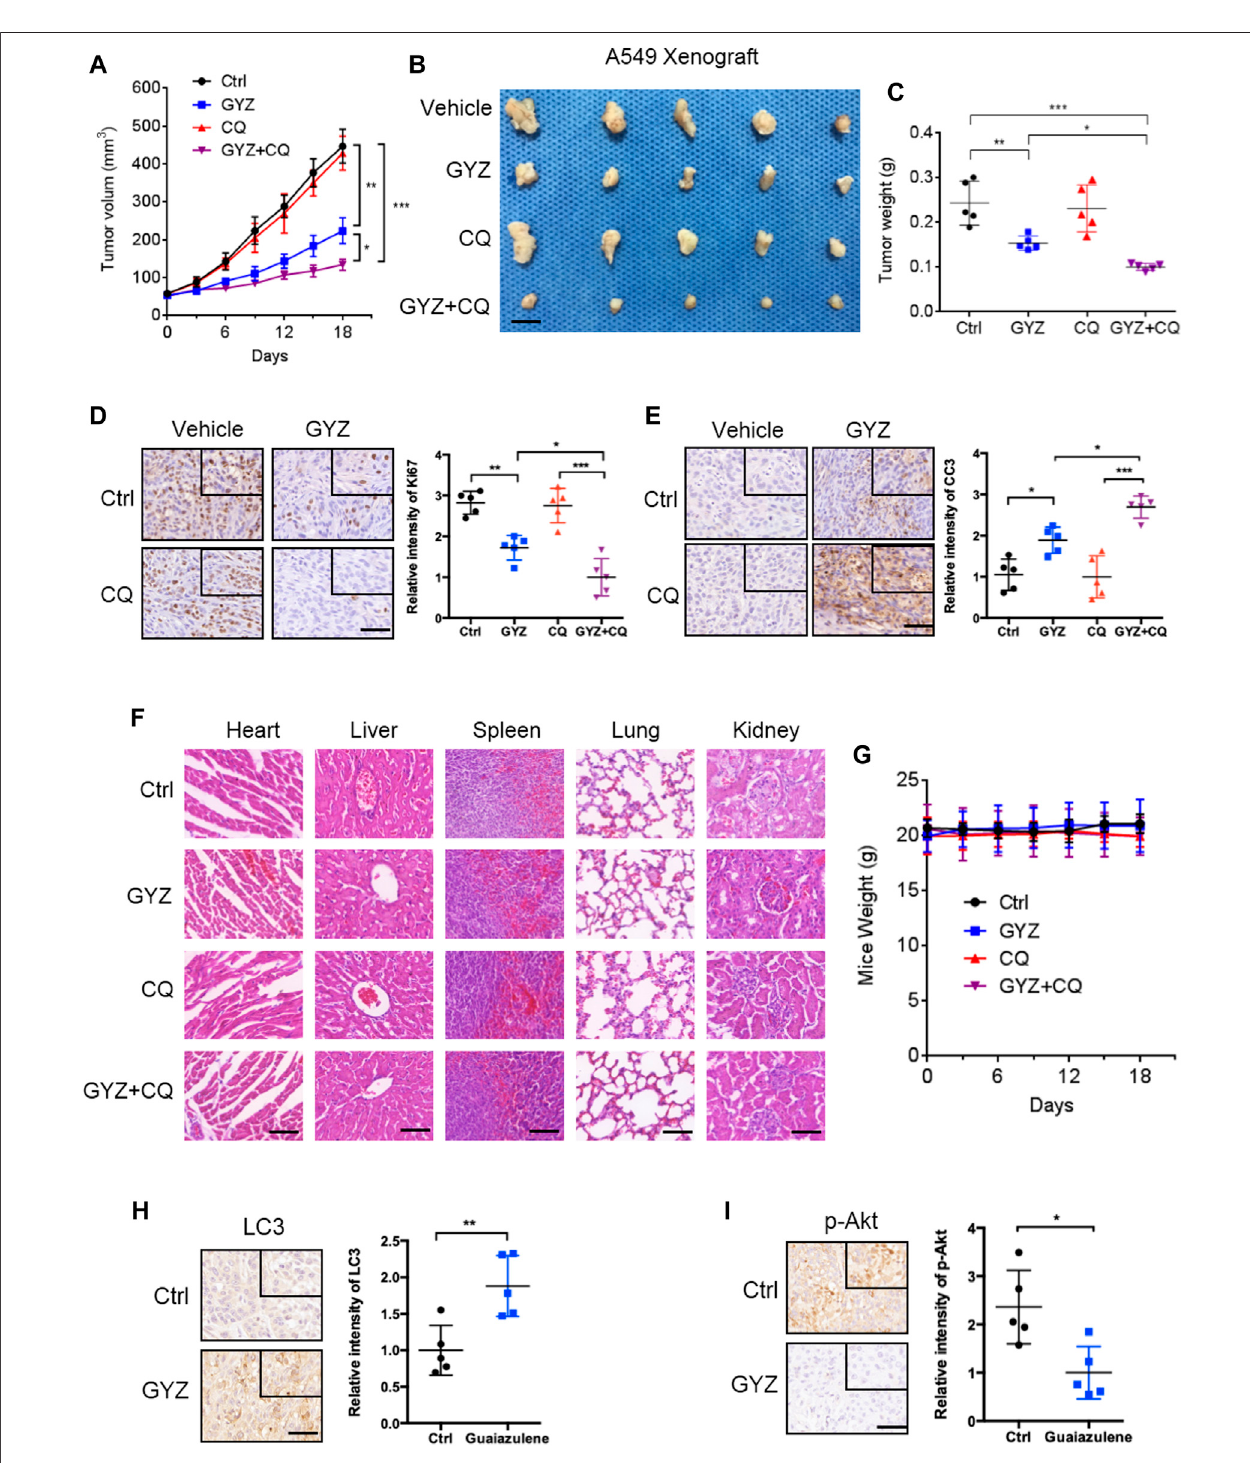
FIGURE 7 | GYZ exhibits antitumor effect against NSCLC in vivo . (A) The volume of tumors from vehicle-, GYZ-, CQ-, or GYZ + CQ-treated mice ( fi ve mice per group) bearing A549 subcutaneous tumor xenografts was examined at the indicated time points. (B) The images of isolated tumors were shown. The isolated tumors wereA549subcutaneoustumorxenograftsfromvehicle-,GYZ-,CQ-,orGYZ+CQ-treatedmice.Scalebars,1 cm. (C) Theweightoftumorsfromvehicle-,GYZ-,CQ-,or GYZ+CQ-treated group. (D) Immunohistochemistry analysis for Ki67 expression in tumor tissues from A549 xenografts treated with vehicle, GYZ (25 mg/kg/day), CQ (15 mg/kg/day), or GYZ+CQ. Scale bars, 50 μ m. (E) Immunohistochemistry analysis for cleaved-caspase 3 expression in tumor tissues from A549 xenografts treated with vehicle, GYZ (25 mg/kg/day), CQ (15 mg/kg/day), or GYZ+CQ. Scale bars, 50 μ m. F) Hematoxylin and eosin staining of the lung, liver, heart, spleen